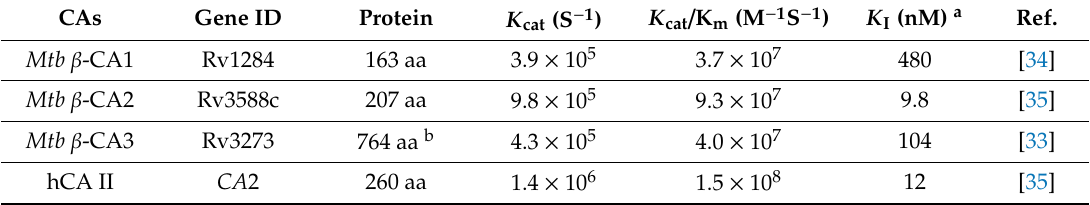
Table 1. Activity and inhibition kinetics of Mtb β -CAs compared to human CA II.